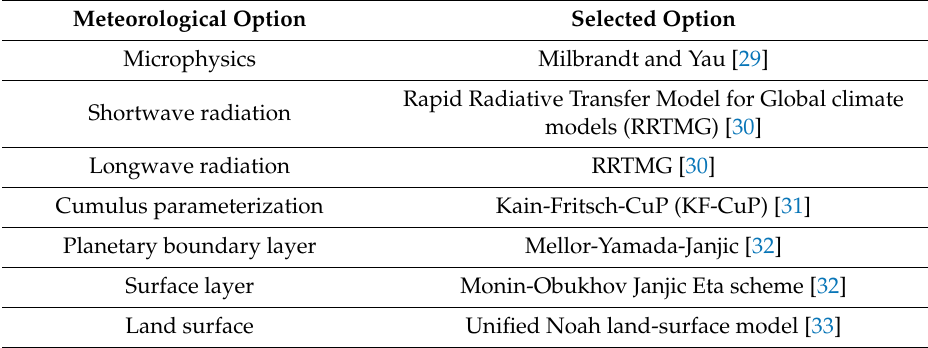
Table 1. Parameterizations and options used for the WRF